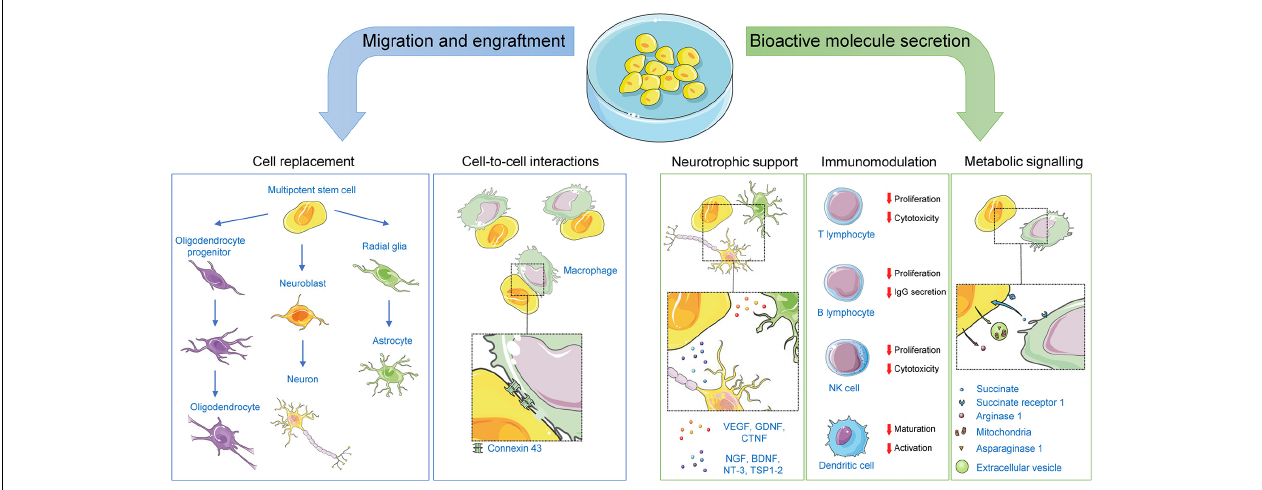
FIGURE 2 | Mechanisms of action for non-hematopoietic stem cells. Following transplantation, non-hematopoietic stem cells can exert their therapeutic effects by: (1) replacing damaged CNS cells; (2) offering neurotrophic support to CNS cells via paracrine and juxtracrine signaling; (3) affecting immunomodulatory functions on both the innate and adaptative immune systems via paracrine and juxtracrine signaling, or via direct cell-to-cell contacts; and (4) engaging in metabolic signaling with cells within their niche. Representative examples of key players in each mechanism are illustrated. BDNF, brain-derived neurotrophic factor; CNTF, ciliary neurotrophic factor; GDNF, glial cell–derived neurotrophic factor; NGF, nerve growth factor; NT-3, neurotrophin-3; TSP1-2, thrombospondins 1 and 2; VEGF, vascular endothelial growth